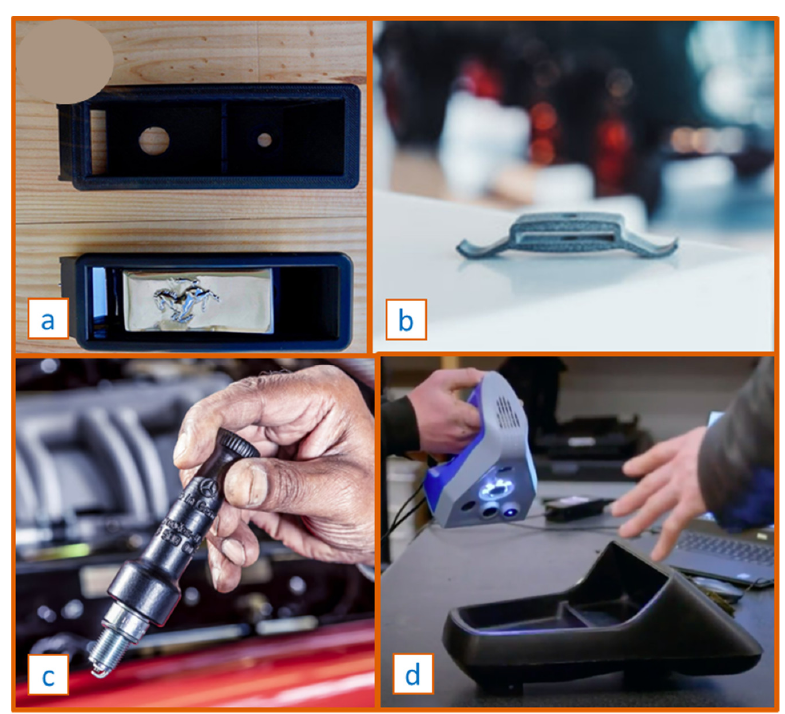
Figure A1. Polymer spare-part reconstruction based on direct AM processes: ( a ) Ferrari 328 hood- release handle (photo credits: SAS Gryp 3D). ( b ) Sliding sunroof rollers for Mercedes-Benz W 110, W 111, W 112, and W 123 model series (photo credits: Mercedes-Benz Group AG). ( c ) Spark-plug holder for Mercedes-Benz 198 model series (Coupé and Roadster) (photo credits: Mercedes-Benz Group AG). ( d ) Central console of a 1970s Mark III Ford Cortina (photo credits: Car SOS, Renegade Pictures).